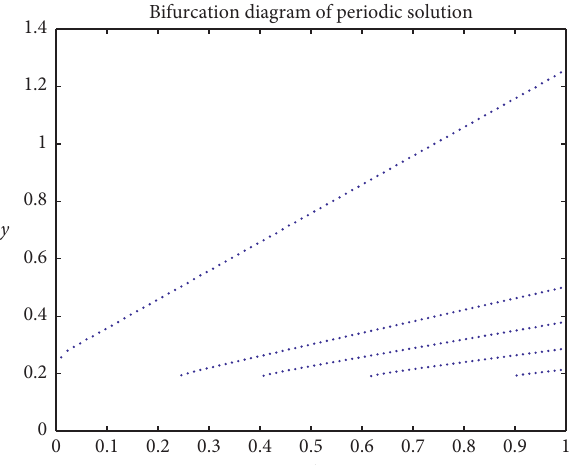
Figure 14: Bifurcation diagram of system (12) with respect to τ for τ ∈ [0, 1].